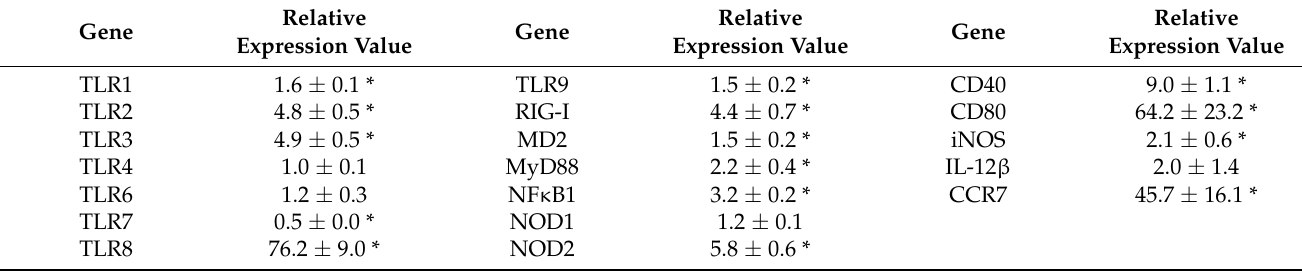
Table 2. The mRNA expressions of PRRs and M1-phenotype macrophage